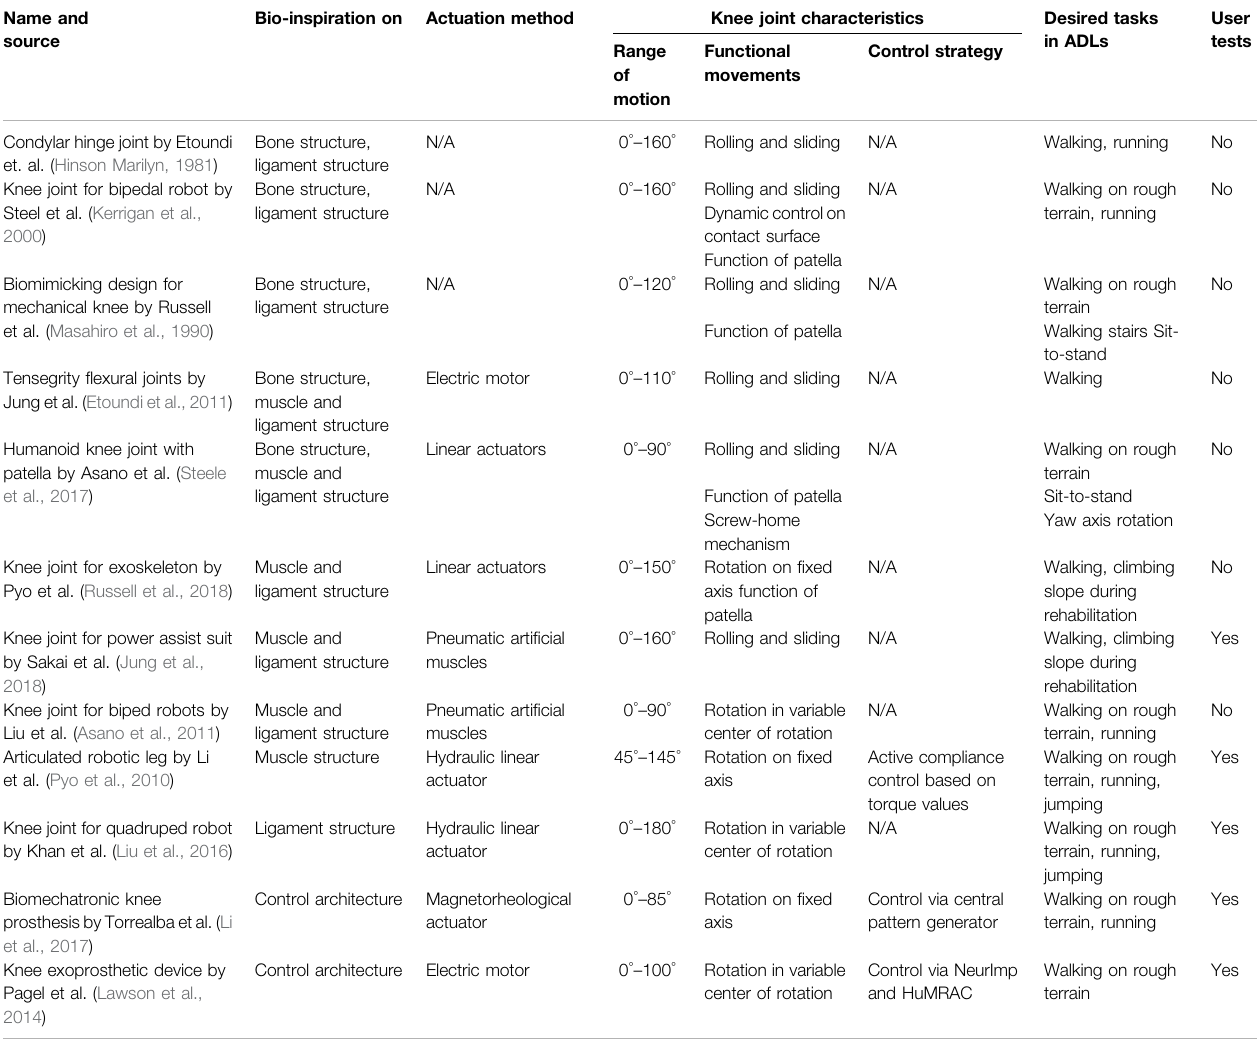
TABLE 1 | General characteristic comparison of modern bio-inspired knee joints at research